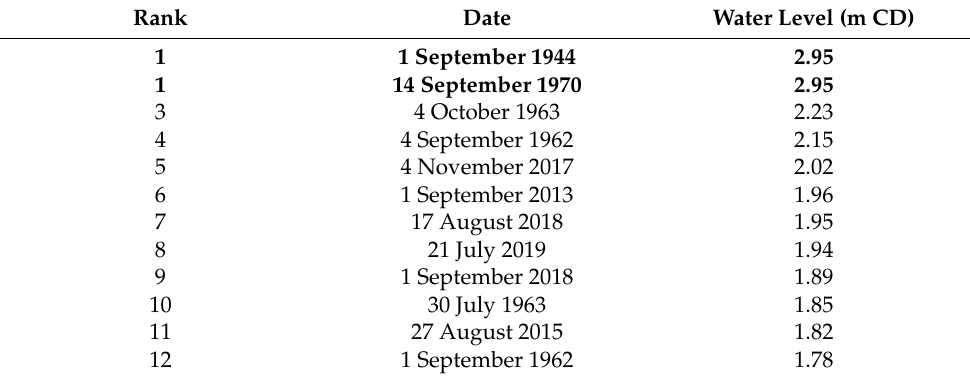
Table 1. The ten highest water levels recorded at the Tuktoyaktuk tide gauge station and the two highest water-level events inferred by Harper et al. [19] from the driftwood line field surveys (shown in bold text).